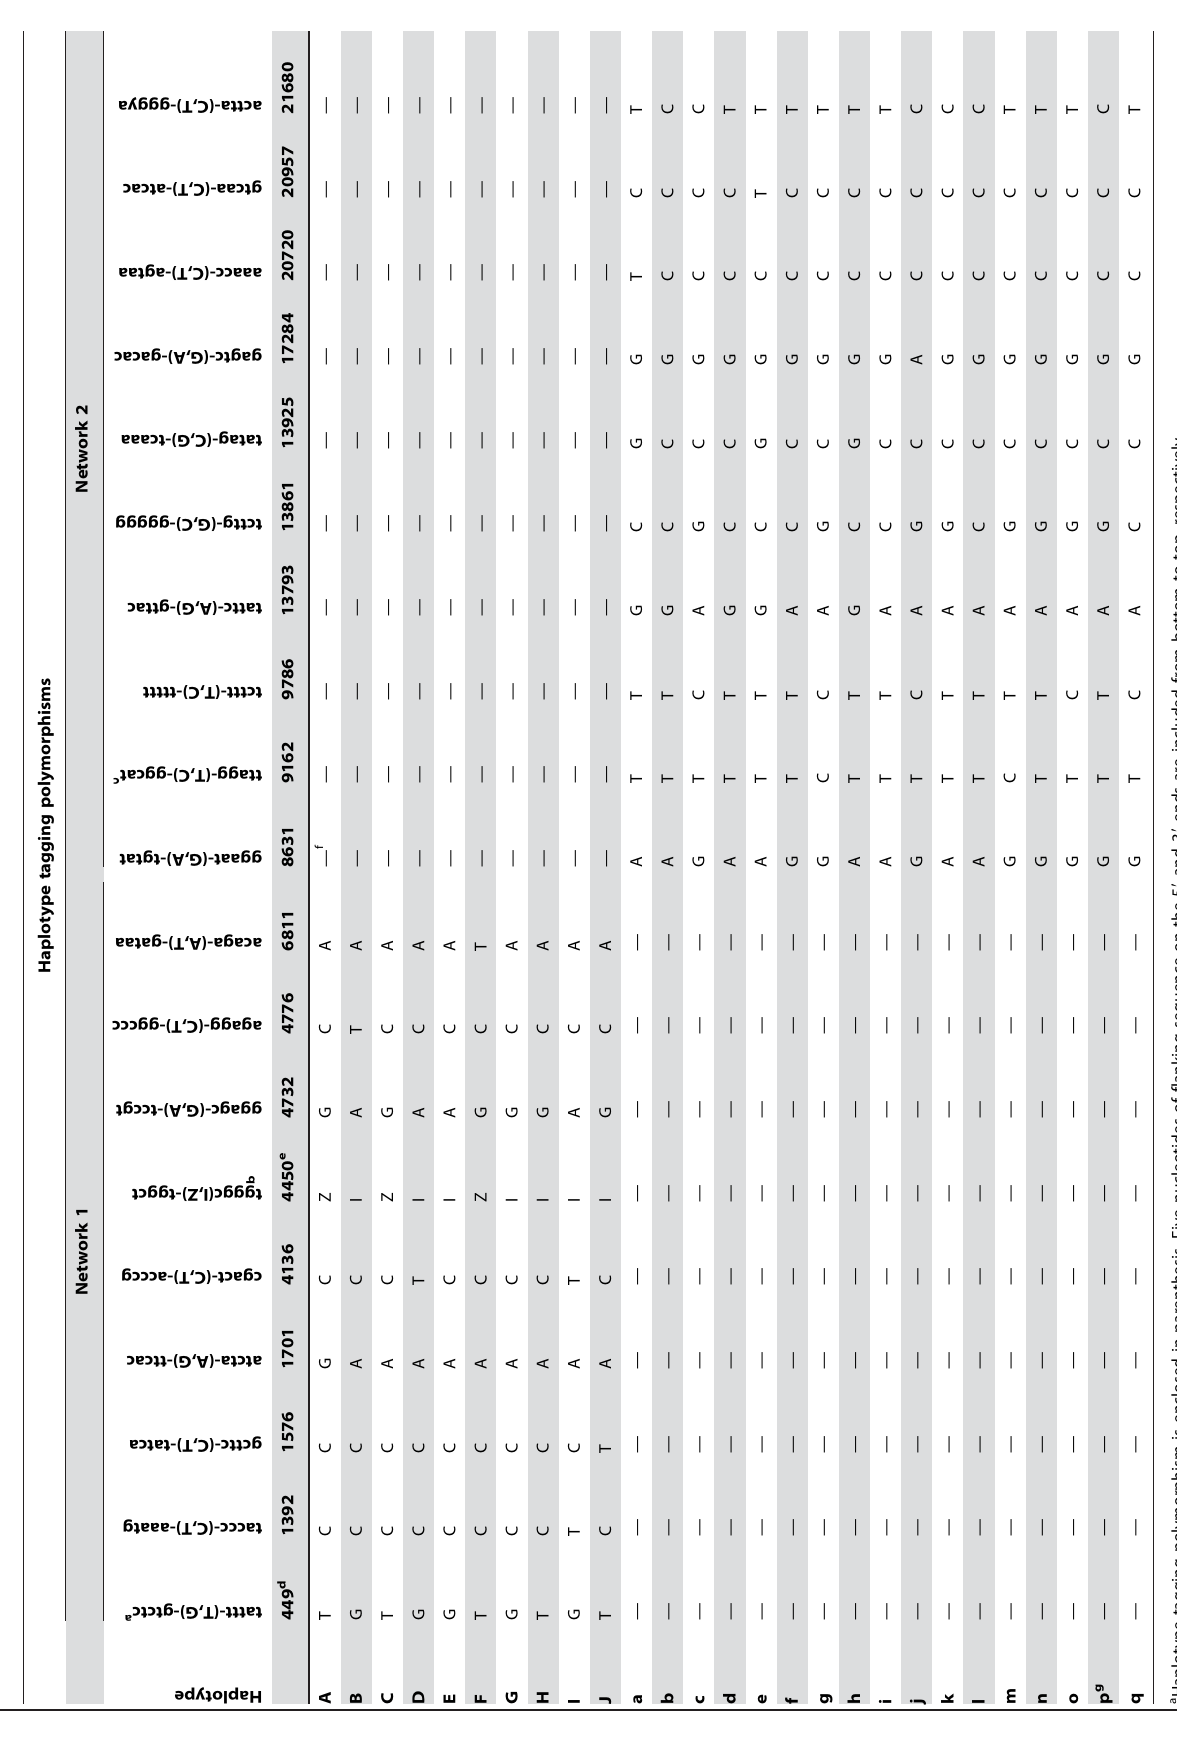
gtcaa-(C,T)-atcac